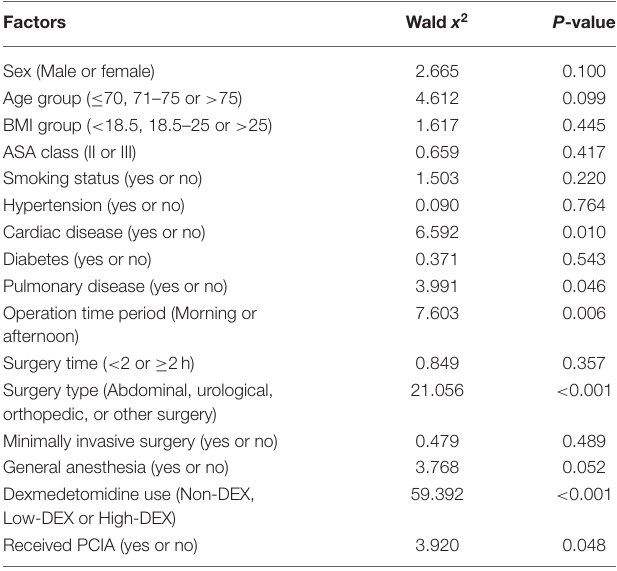
TABLE 2 | Potential effect factors on severe sleep disturbance after surgery in an enter logistic regression analysis model.